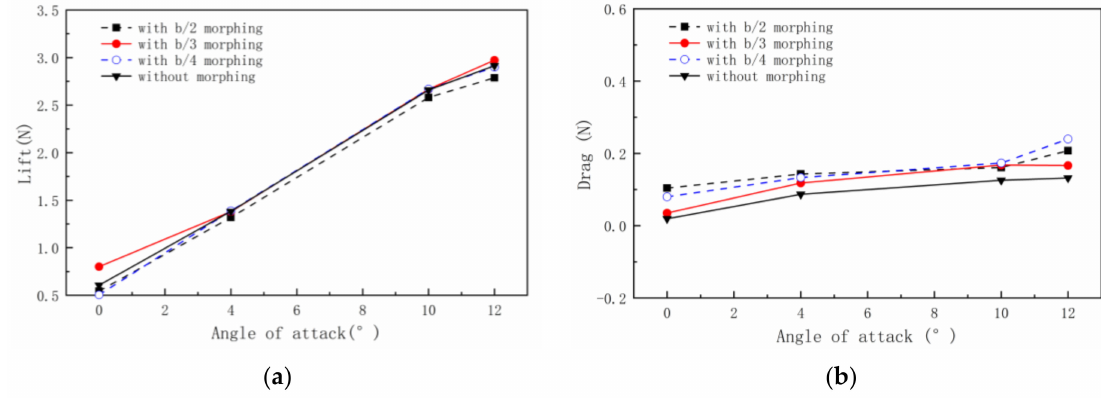
Figure 14. ( a ) Lift force and ( b ) drag force of different wing models at different AOAs.